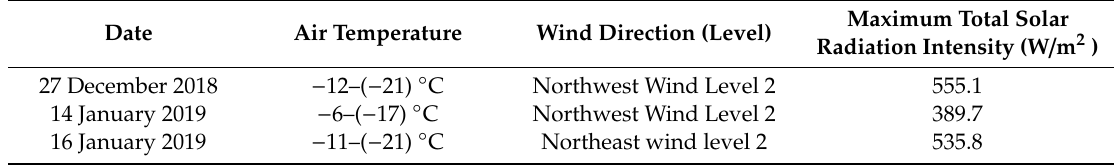
Table 2. Test time and climatic